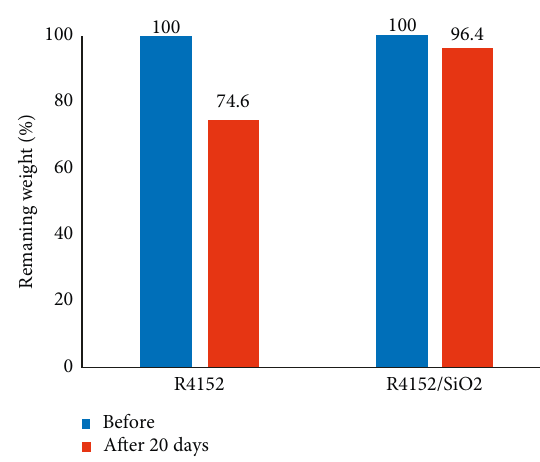
Figure 4: The remaining weight of acrylic coatings without nano- SiO 2 (R4152) and with 2.5wt% nano-SiO 2 (R4152/SiO 2 ) before and after immersion in the saturated Ca(OH) 2 environment for 20